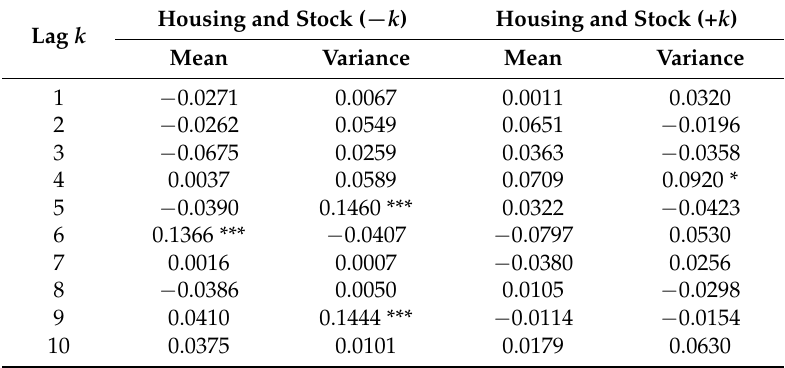
Table 5. Cross-correlation for levels and squares of the standardized residuals. Housing and Stock ( − k ) Housing and Stock (+ k ) Lag k Mean Variance Mean